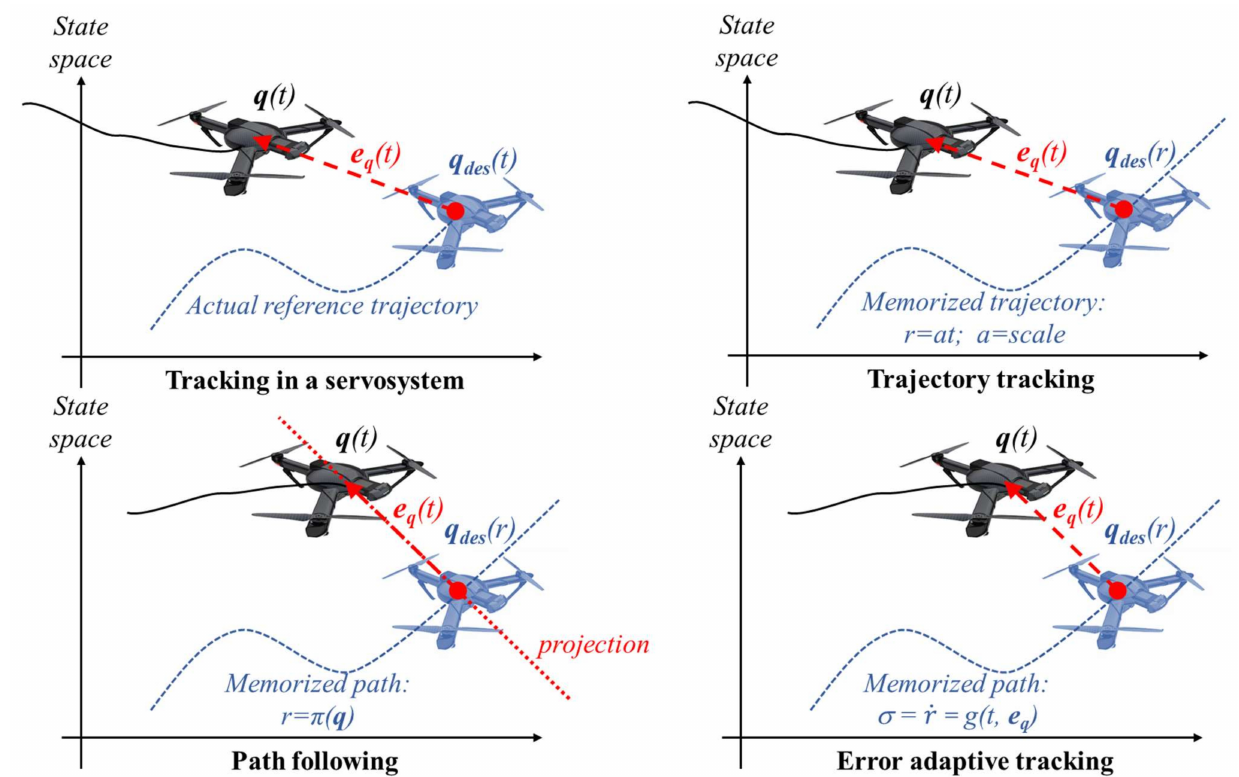
Figure 1. Classification of tracking methods regarding the descriptor